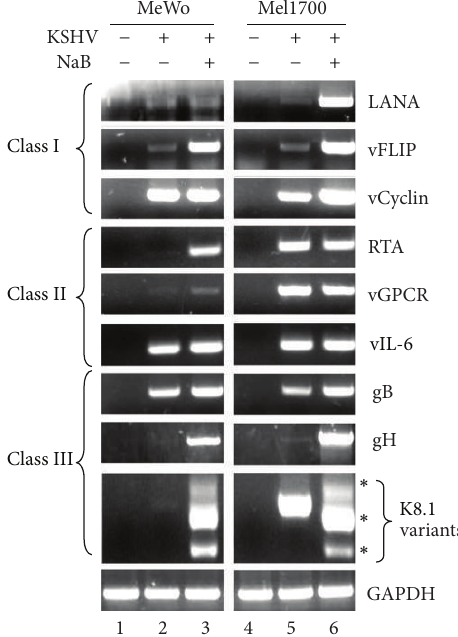
Figure 3: rKSHV.219-infected melanoma cells support the full spectrum of latent and lytic viral gene expression. Total RNA from mock ( − ) or rKSHV.219-infected (+) MeWo and Mel1700 cells either left untreated ( − ) or induced (+) with 2mM NaB for two days was used as template for RT-PCR amplification of viral transcripts using primer sets specific for genes belonging to the latent class I (LANA, vFLIP, vCyclin), latent/inducible class II (RTA, vGPCR, vIL6), or the strictly lytic class III (gB, gH, K8.1) (Table S1). GAPDH was used as a template loading